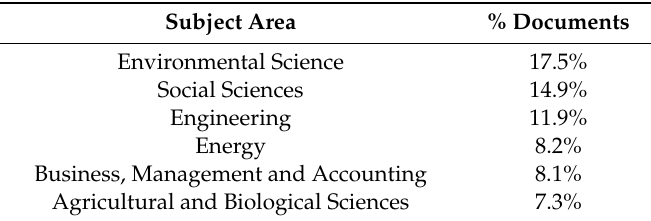
Table 1. Documents by subject areas.